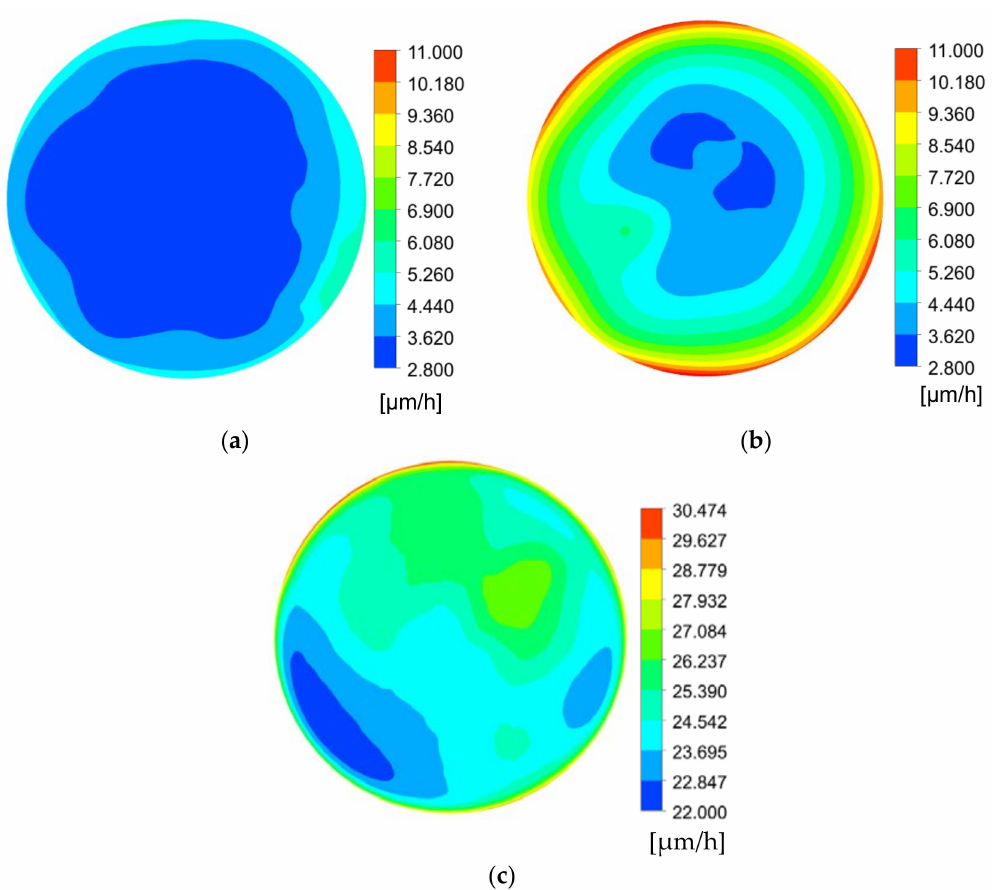
Figure 9. GaN (gallium nitride) growth rates obtained from ( a ) the upside-down reactor at 0.5 bar, ( b ) the normal reactor at 0.5 bar, and ( c ) the upside-down reactor at 2.5 bar.